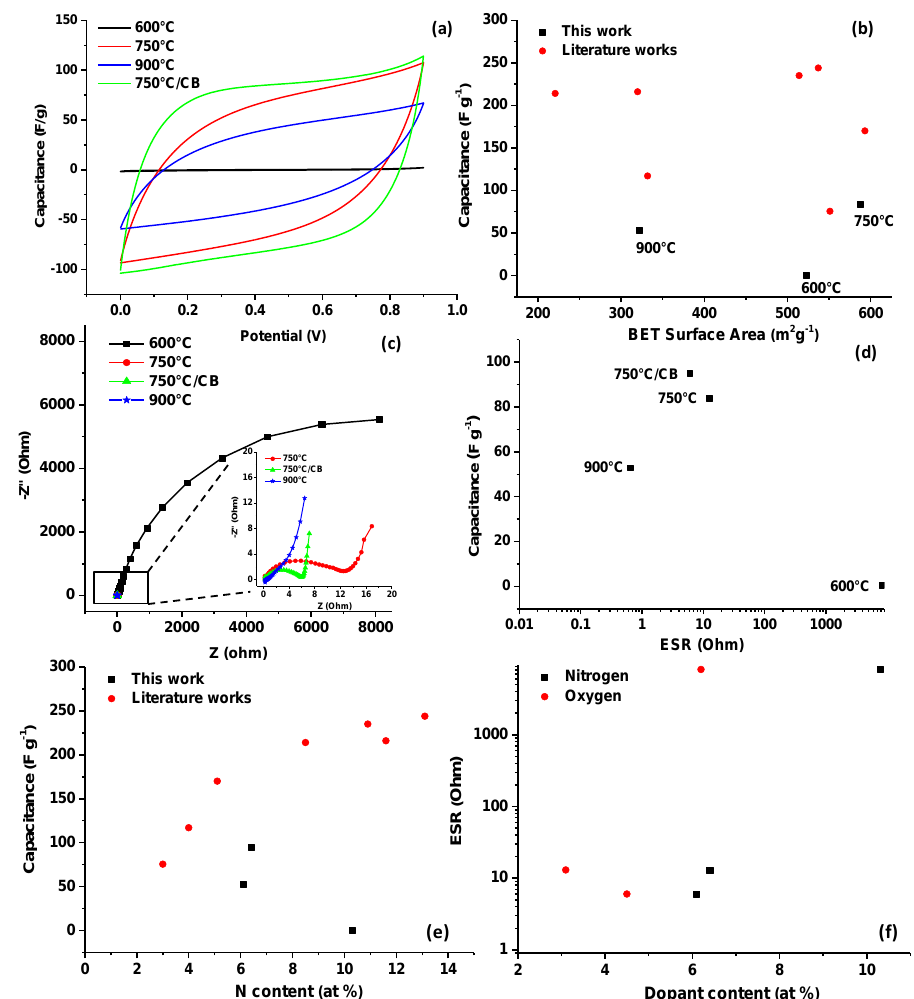
Figure 10. Electrochemical cyclic voltammetry ( a ) and electrochemical impedance spectroscopy, Nyquist plots ( c ) along with the evolution of capacitance vs. BET surface area ( b ) ESR ( d ) and nitrogen content ( e ) of nitrogen-doped carbons prepared in this work and from the literature; evolution of ESR vs. nitrogen and oxygen content in the materials ( f ).